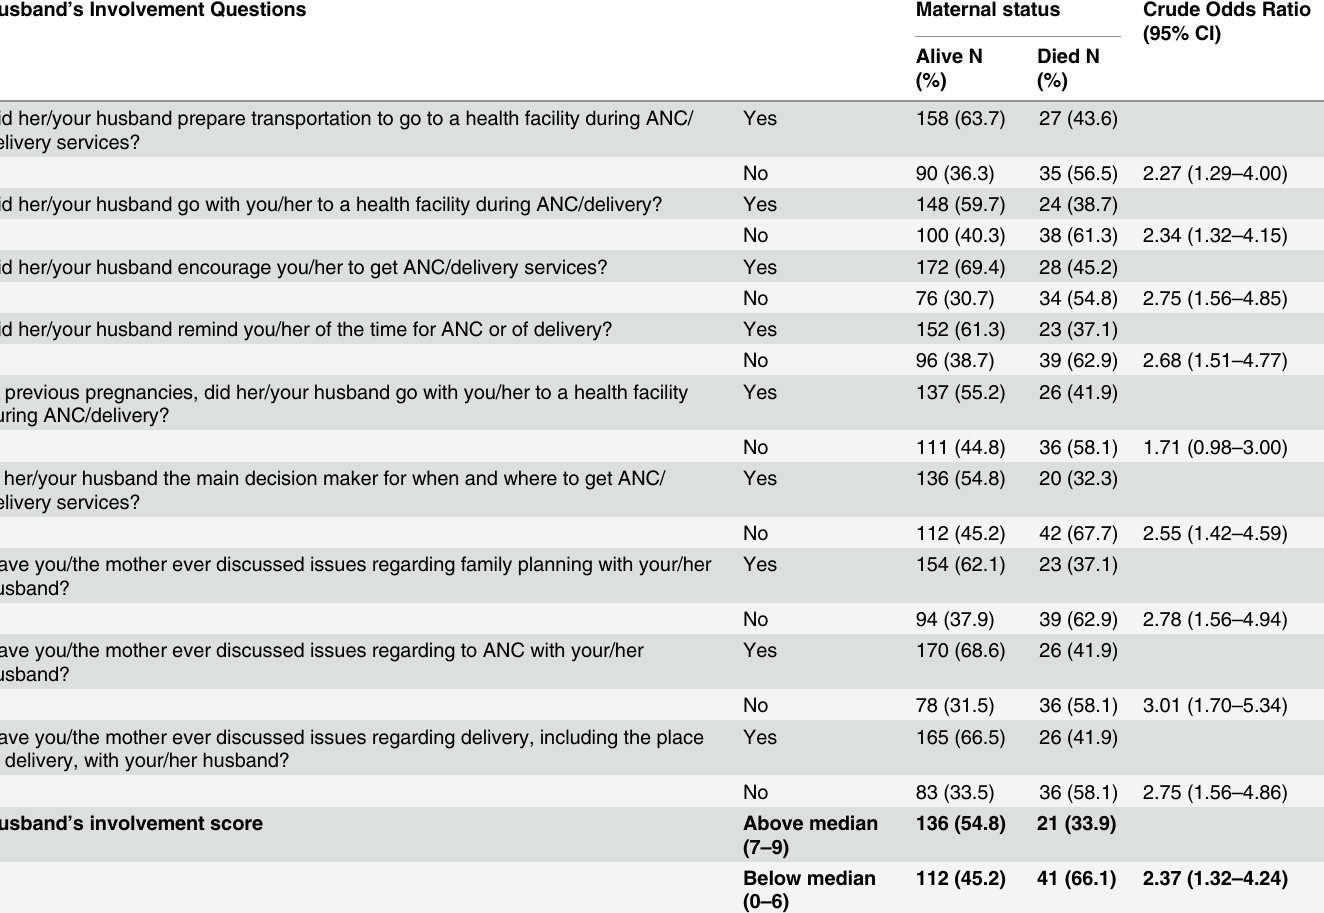
Table 2. Husbands ’ involvement in maternity issues for 62 rural Tigrean women who died of maternal causes and 248 controls (who had given birth in the study period May 2012 to August 2013 and lived in the same communities as the maternal deaths). Husband ’ s involvement score is based on the number of positive responses to the nine